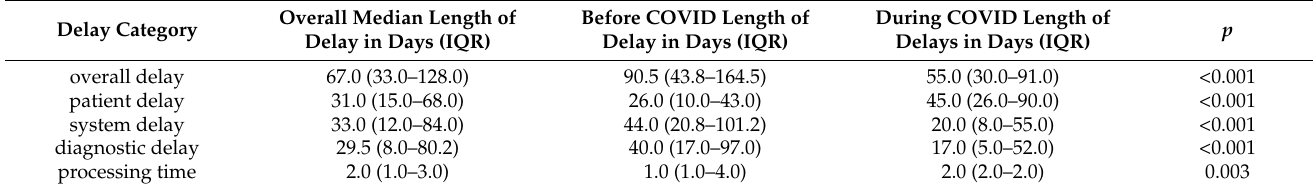
Table 3. Median length of delays (in days) across the ‘before’ and ‘during’ COVID periods. Overall Median Length of Delay Category Delay in Days